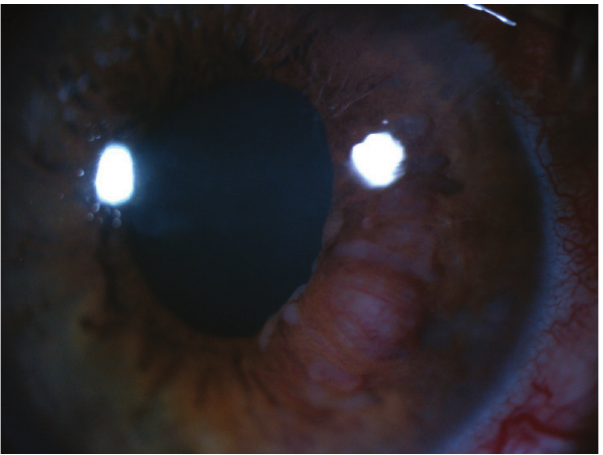
Figure 2. Amelanotic, nodular, and vascularized iris mass with prominent feeder vessels.